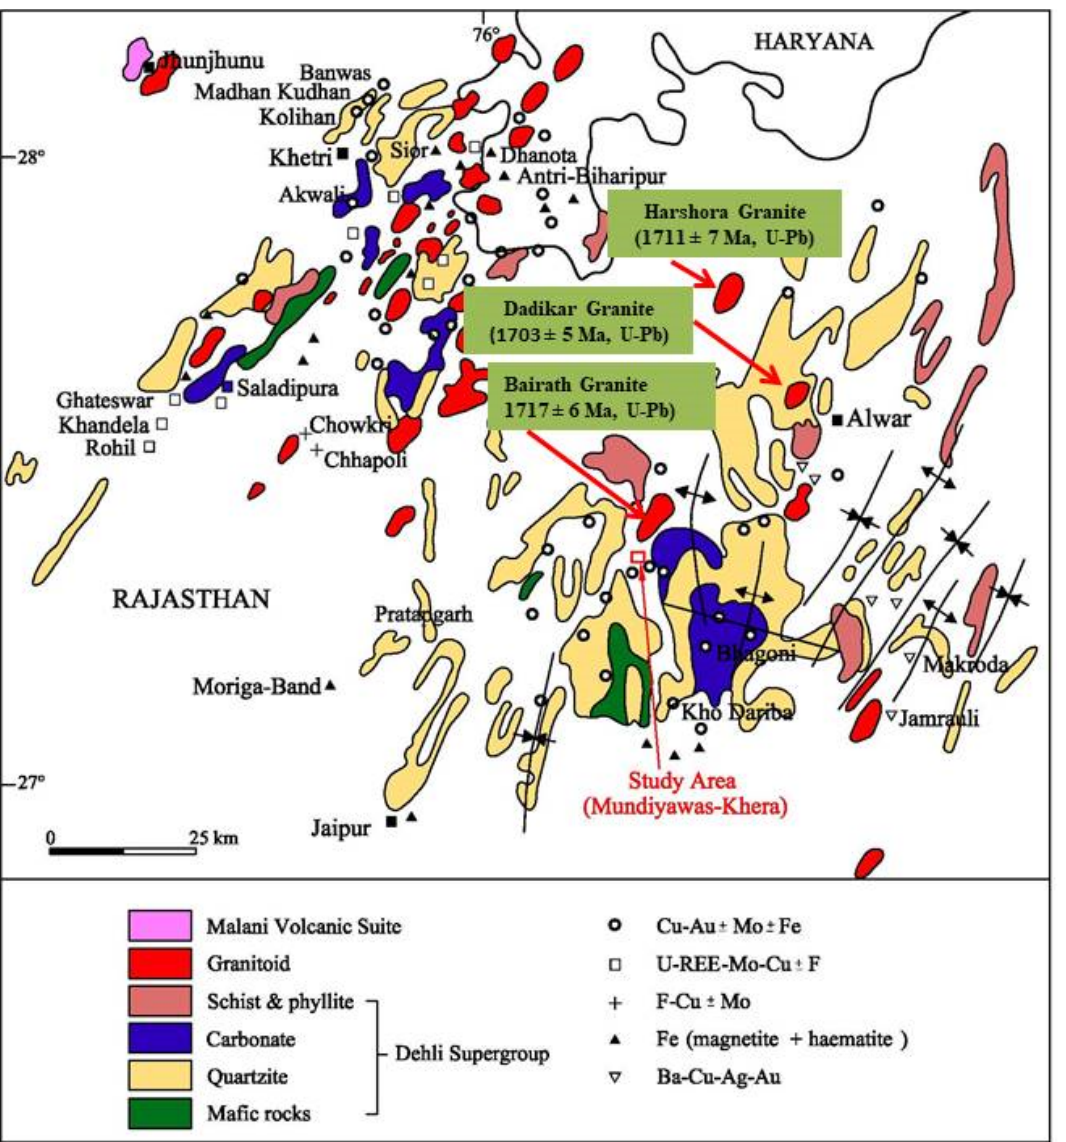
Figure 2. Regional geological map of northern Rajasthan and Haryana showing the disposition of Khetri copper belt (KCB) and Kho-Dariba deposit (modified after [11]). The ages of Harshora Granite, Dadikar Granite and Bairath granite are zircon U–Pb age [28].